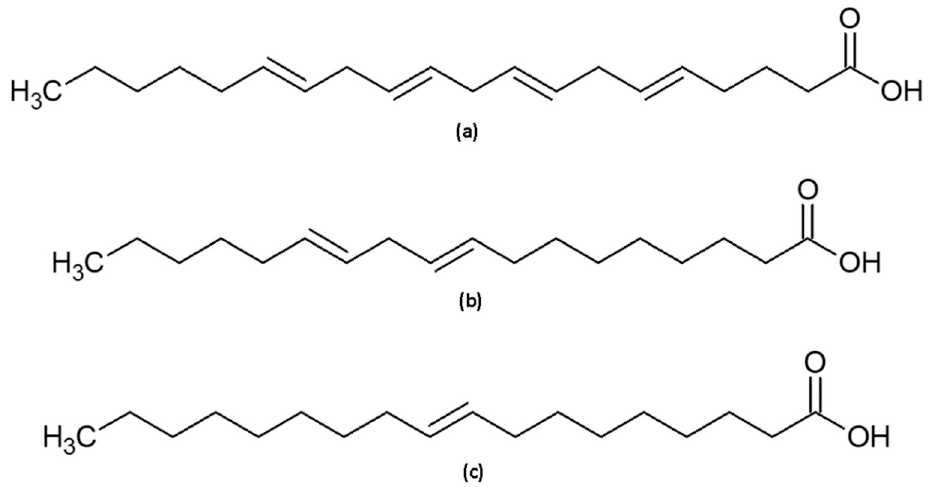
Figure 4. Chemical structure of the FFAs in the mixture: ( a ) arachidonic acid, ( b ) linoleic acid and ( c ) oleic acid.